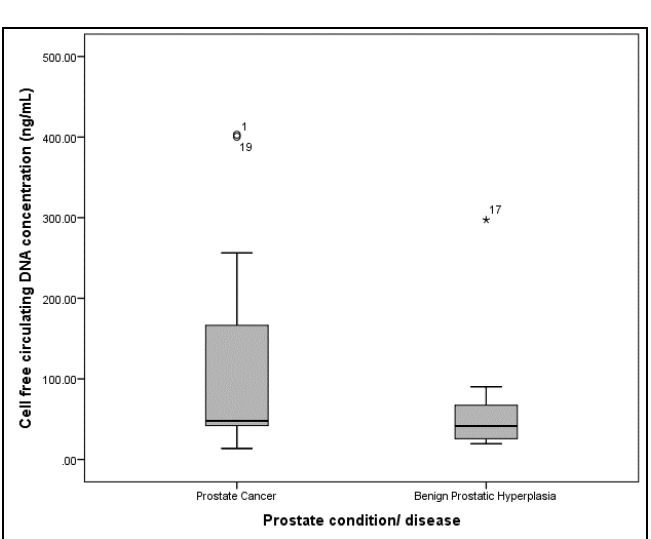
Figure 1. Box plot for the plasma cell free circulating DNA concentration of prostate cancer and benign prostatic hyperplasia patients. Note that ◦ and * represents outliers.